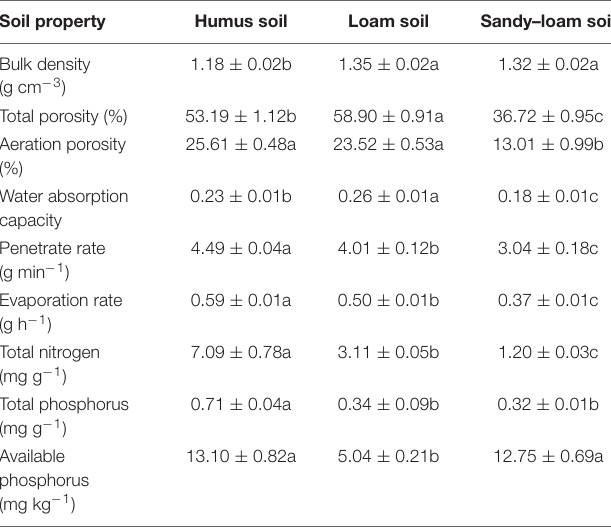
TABLE 1 | Physicochemical properties of three soil